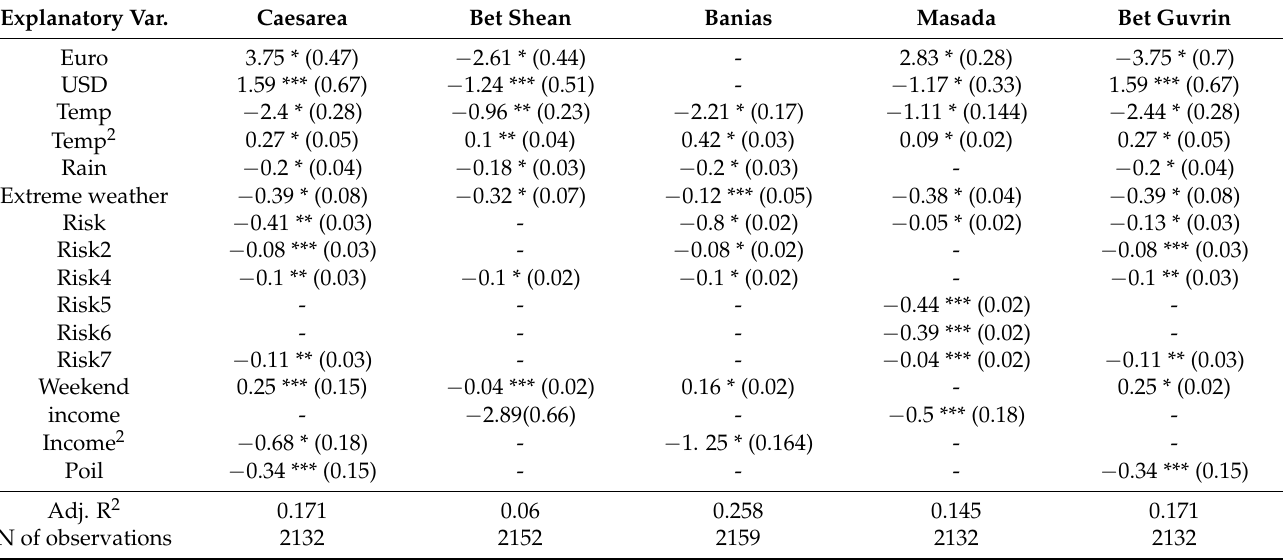
Table 3. Regression results for the number of domestic tourists visiting each national park. Explanatory